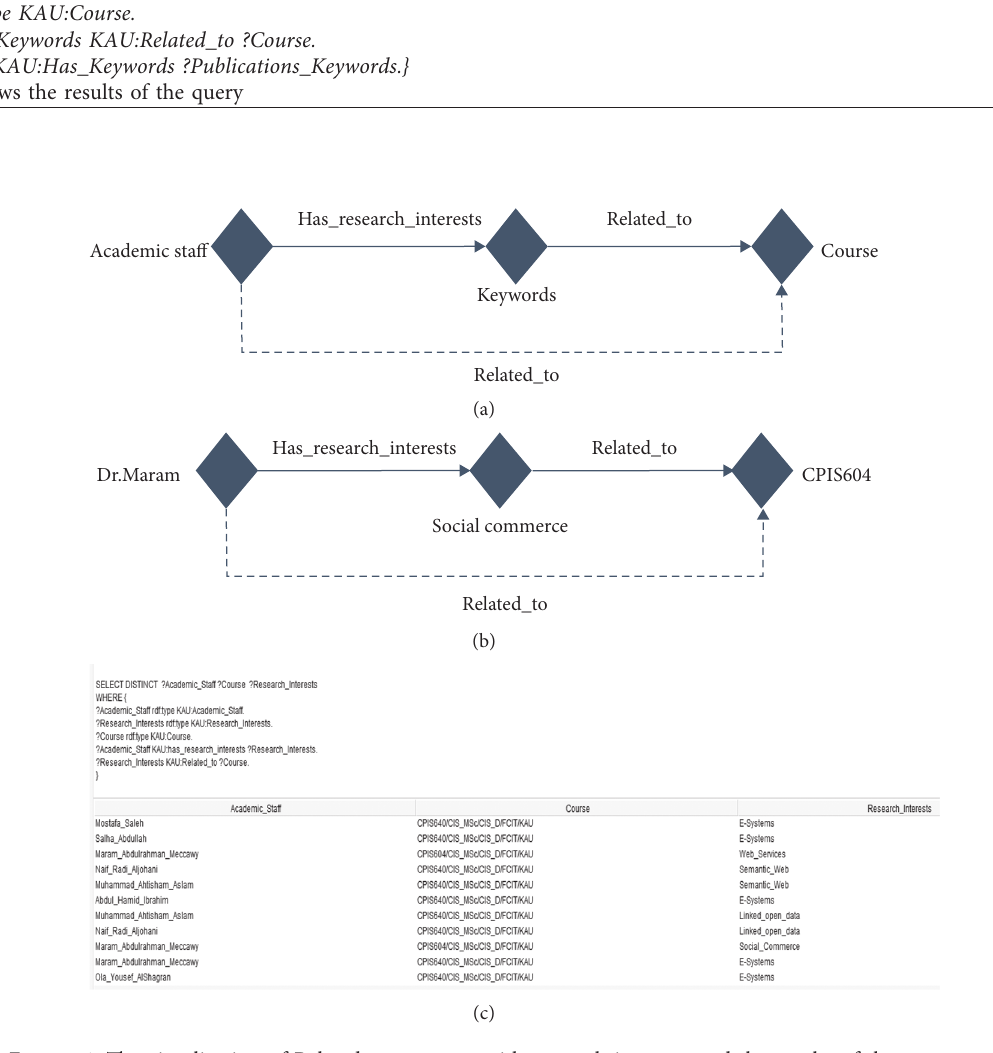
Figure 4: The visualization of Related_to property with research interests and the results of the